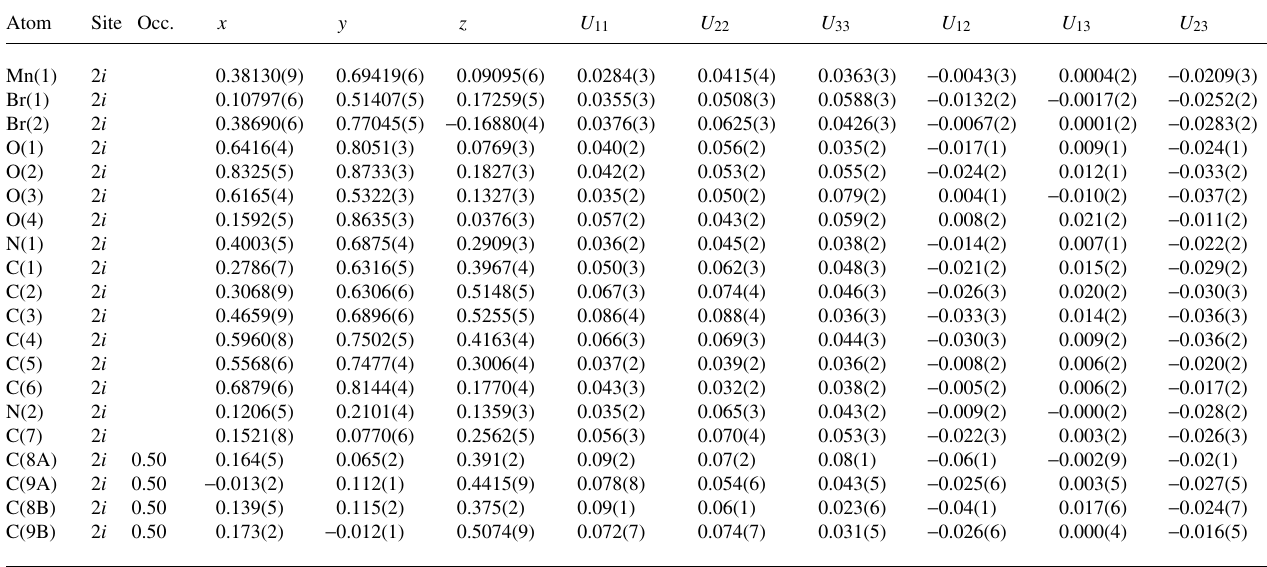
Table 3. Atomic coordinates and displacement parameters (in Å 2 ) .